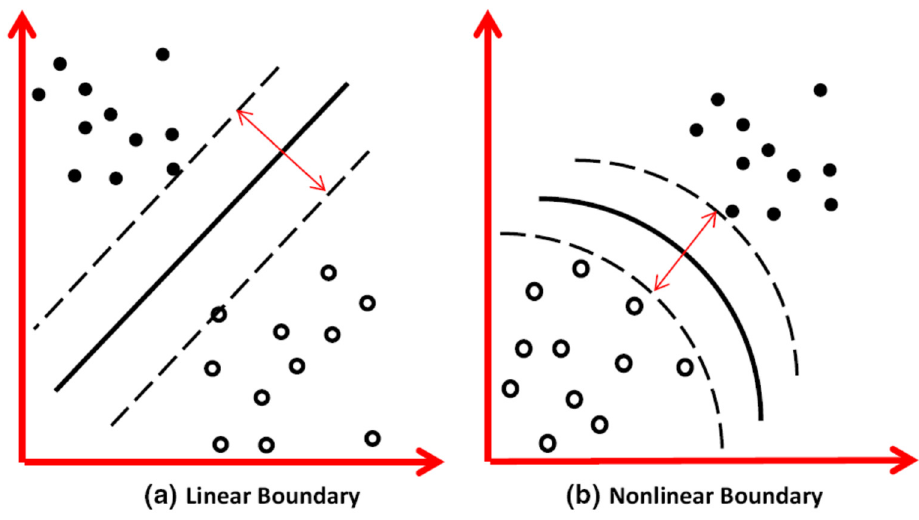
Figure 6. Support vector machine SVM in 2-D space.